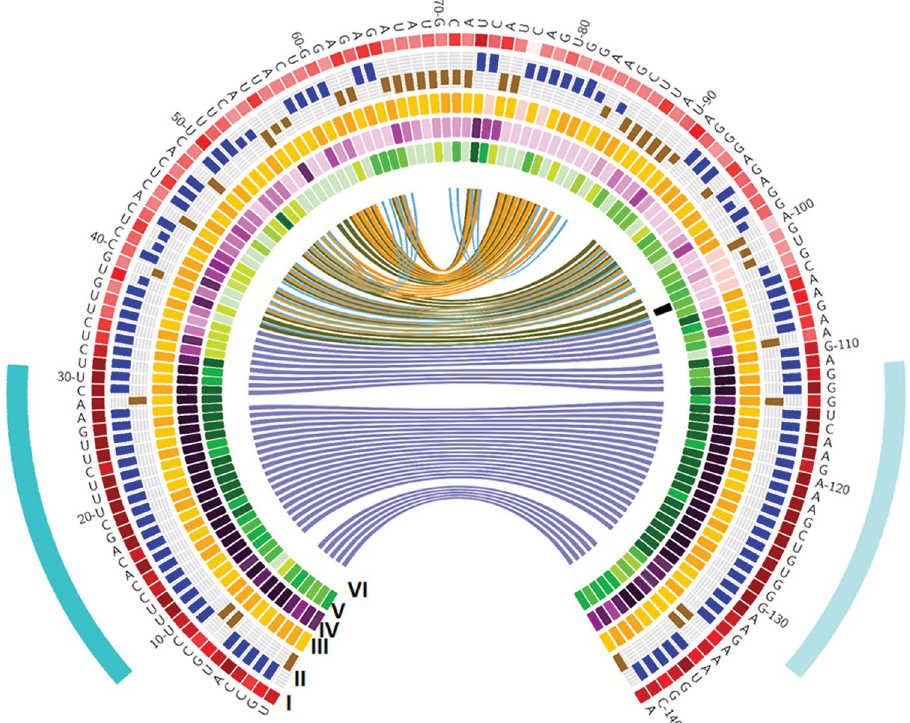
Figure 3. Circos analysis of sequence and structural conservation of pre- miR396c Oryza , dicot and monocot species. Ring I represents overall conservation of bases; ring II represents a histogram depicting frequency of base pairing (blue bars) and unpaired bases (brown bars) in Oryza species. Ring III represents conservation score for each base among O ryza species; darker colour indicates a higher conservation score (9) while a lighter colour indicates lower conservation score (1). Ring IV and Ring V represents the conservation scores observed for dicot and monocot species respectively. Ring VI represents the SNP observed in 3024 O. sativa